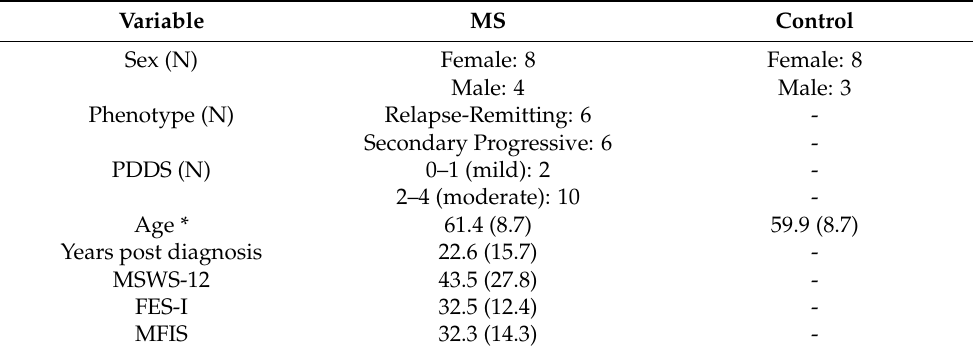
Table 1. Sample demographics. Sample sizes (N) and mean (standard deviation) of variables are reported as appropriate. * Note that all participants are included with a subset of eight being age- and sex-matched. Within group analyses contained all participants whereas between group analyses contained only age- and sex-matched